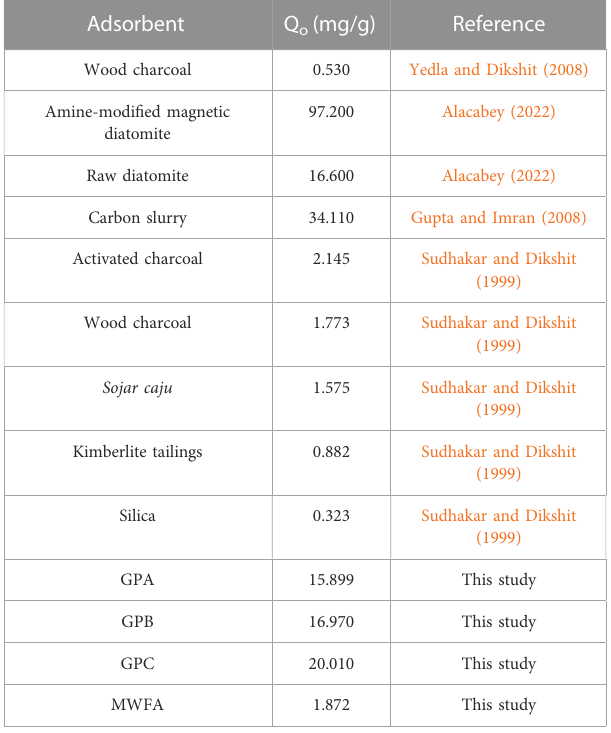
TABLE 5 Comparison of adsorption capacities of MWFA-based geopolymers with other adsorbents for endosulfan. Adsorbent Q o